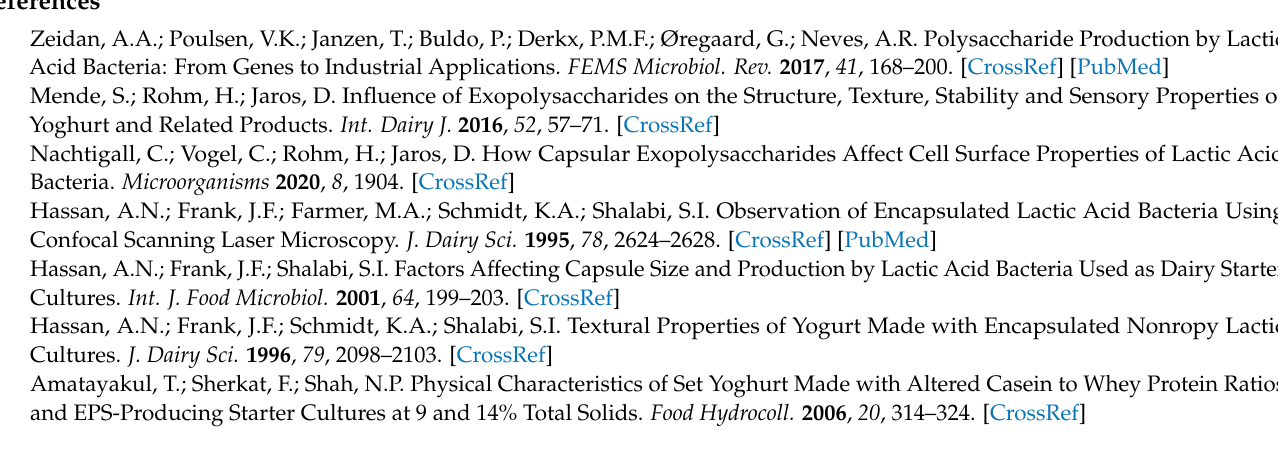
Figure S2: 1 H-NMR spectrum of fEPS from ST-2E. The signal annotation in the anomeric region was